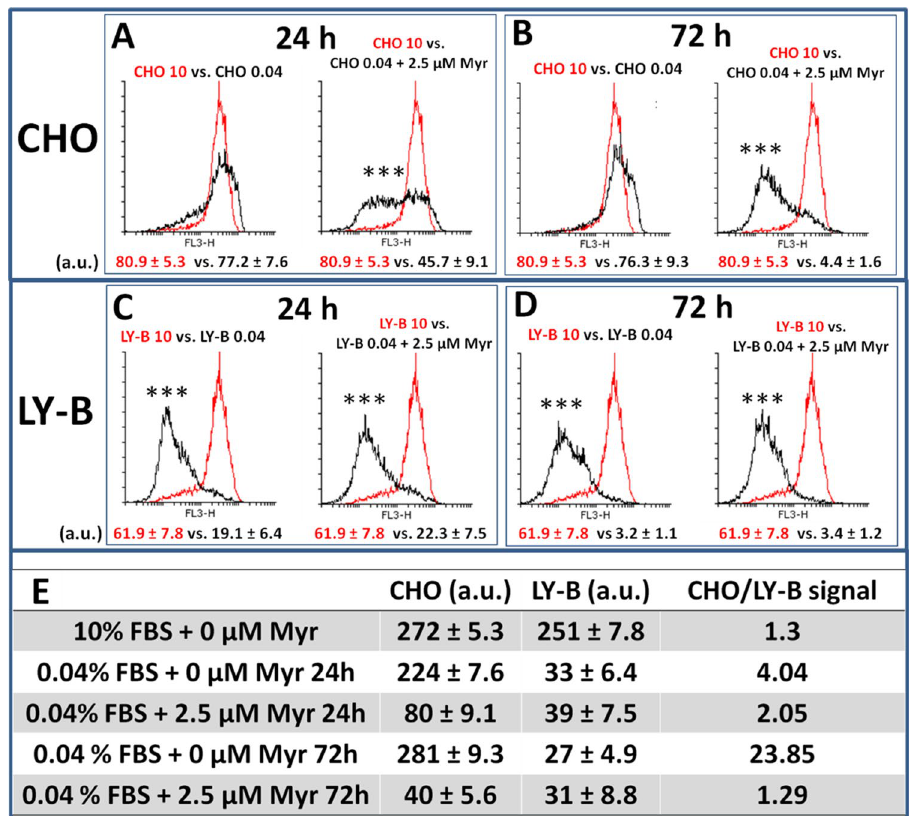
Figure 3. FACS-mediated, quantification of cell staining with SM specific mCherry-lysenin as a function of time. CHO cells grown in standard medium vs. myriocin-treated or non-treated CHO cells grown in deficient medium for 24 h ( A ) or 72 h ( B ). LY-B cells grown in standard medium vs. treated or non-treated LY-B cells grown in deficient medium for 24 h ( C ) or 72 h ( D ). Total CHO and LY-B lysenin-mCherry signals and CHO/ LY-B lysenin-mCherry signal ratios ( E ). Histograms in red correspond to control cells (CHO or LY-B grown in standard-medium); histograms in black correspond to the samples of interest, as indicated in each case. Geometric mean ± S.D. (n = 3). Representative histograms are shown; three independent experiments were performed counting 10,000 cells in each case. Statistical significance was calculated with the Student’s t-test, *** P <